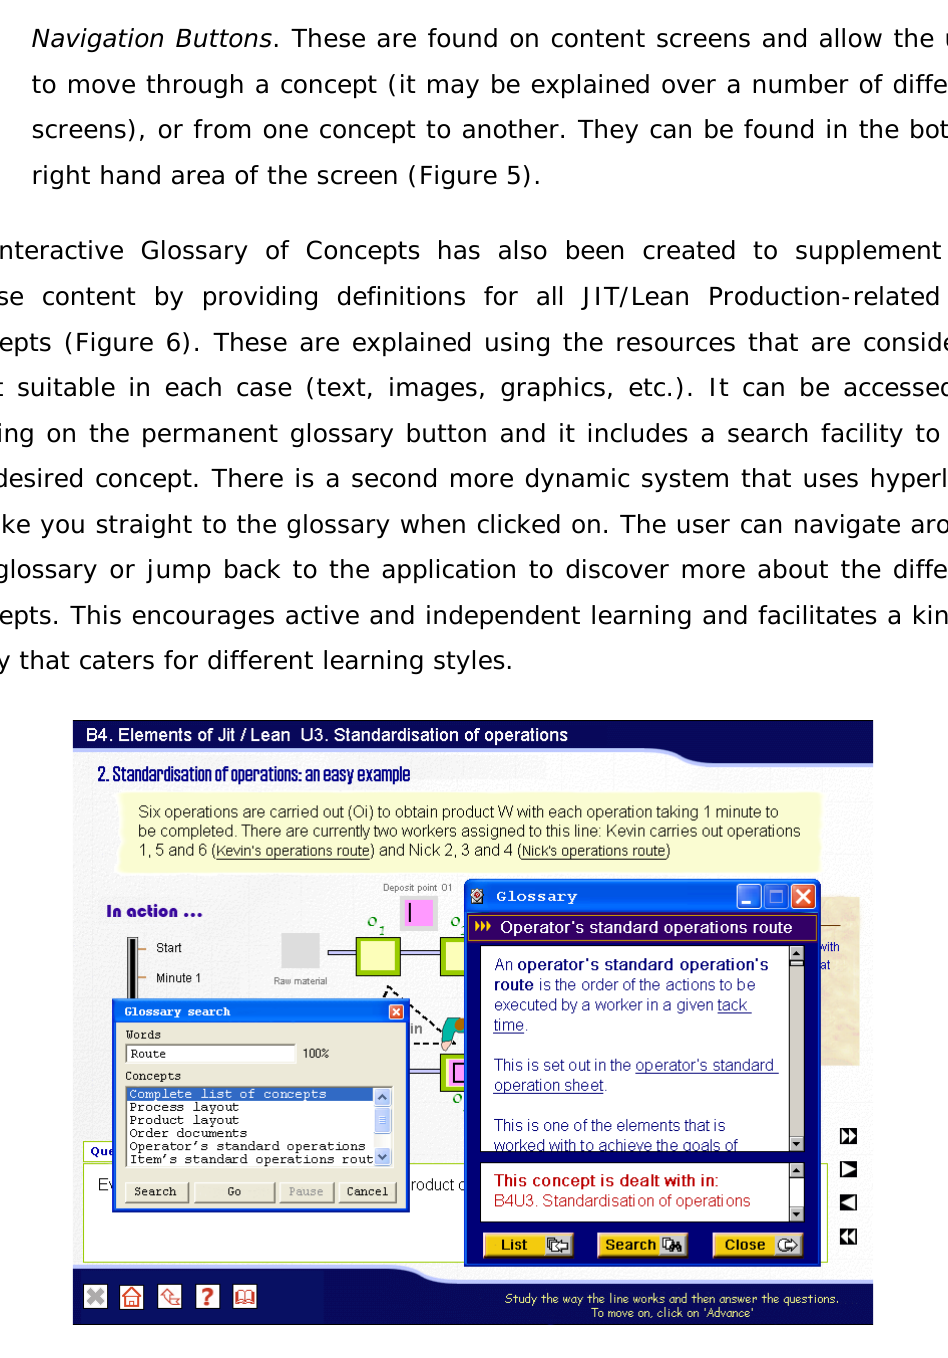
Figure 6. “Glossary of Concepts with search tool